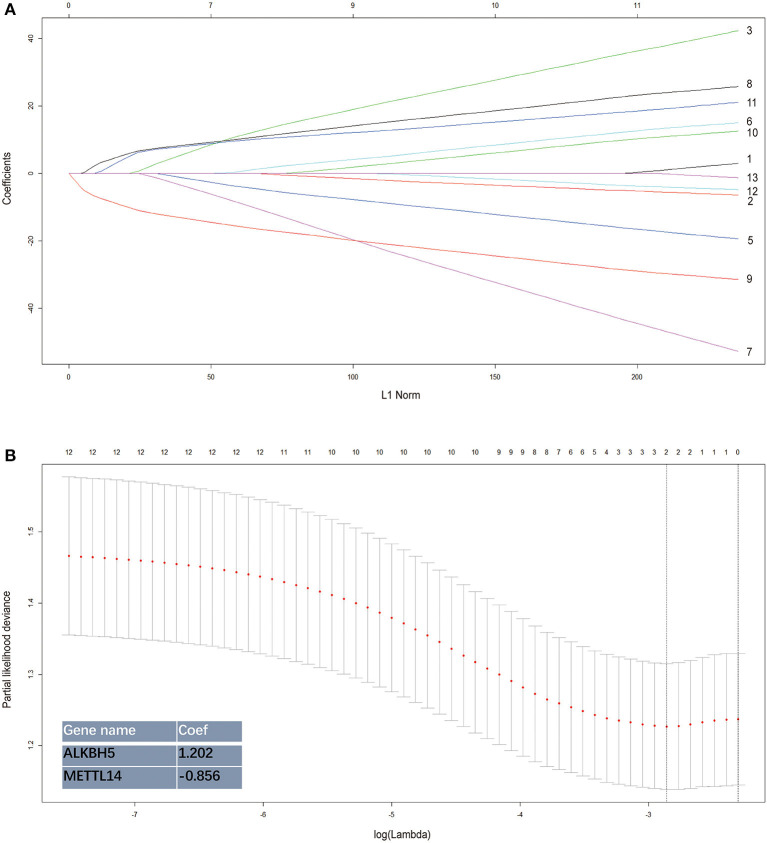
Establishment of the risk signature integrating the 2 m6A RNA methylation regulators. The coefficients estimated by the Lasso regression method are presented. Each curve in the (A) represents the path of a lasso coefficient against the L1-norm (the penalty term for lasso) when λ changes. A coefficient that becomes non-zero when λ changes enters the LASSO regression model. (B) The coefficients estimated by the Lasso regression method are presented.